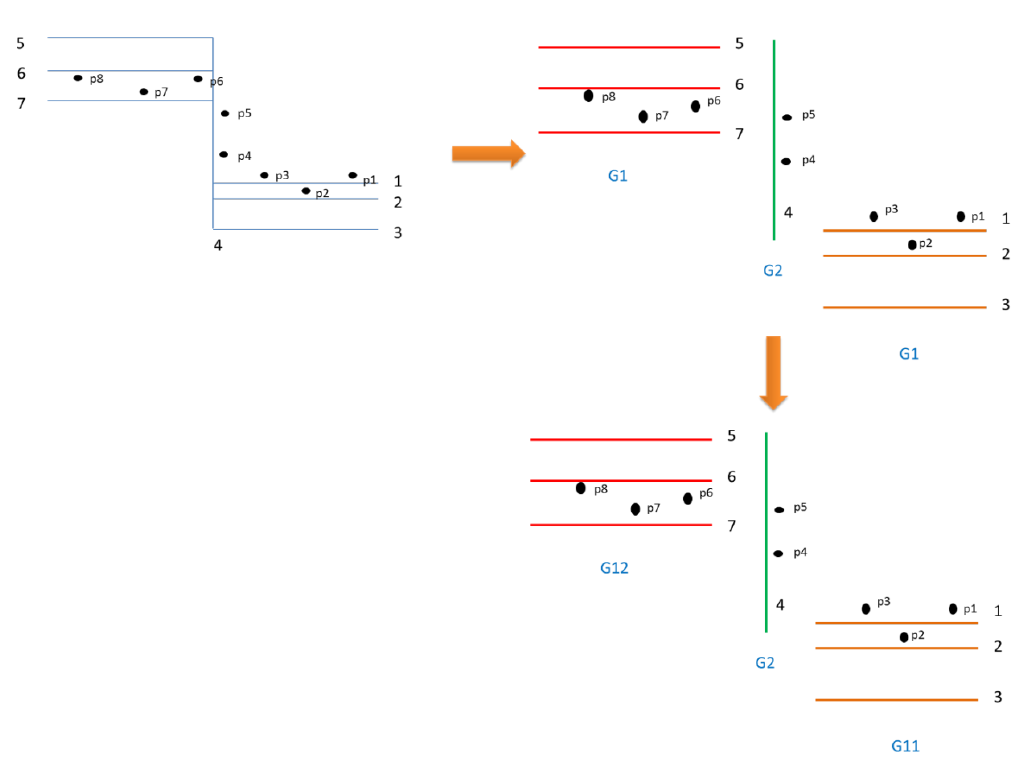
Figure 2. Two-step signal point